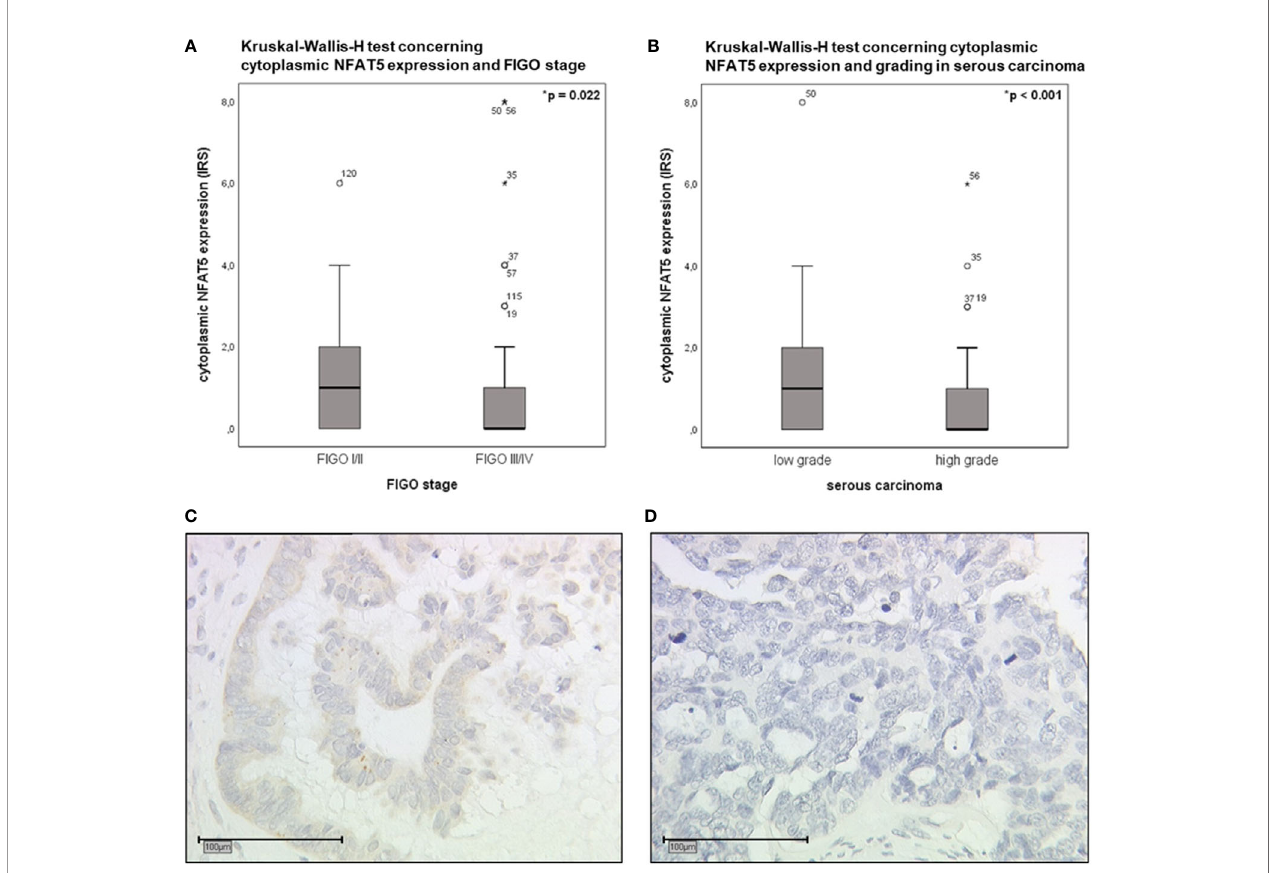
FIGURE 6 | Boxplot analysis of cytoplasmic NFAT5 expression (Kruskal-Wallis-H test). (A) Boxplot analysis of cytoplasmic NFAT5 expression comparing FIGO I,II (n=37, median IRS=1) to FIGO III,IV (n=89, median IRS=0; p =0.022). (B) Boxplot analysis of cytoplasmic NFAT5 expression in serous carcinoma (n=89) comparing low grading (n=26, median IRS=1) to high grading (n=63, median IRS=0; p <0.001). (C, D) Exemplary photographs (25x magni fi cation; scale bar=100µm) of cytoplasmic NFAT5 expression in serous histological subtype, comparing positive expression in low grade ( C , IRS=4) to negative expression in high grade ( D , IRS=0)